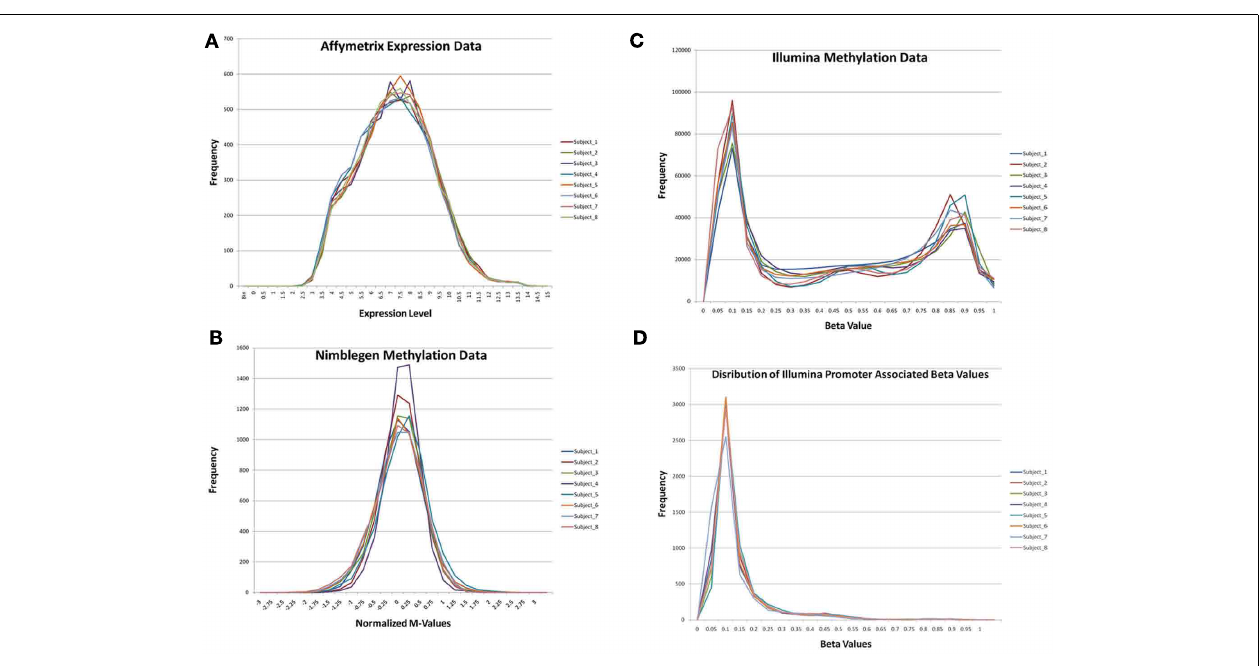
FIGUREA1 | Distribution of raw